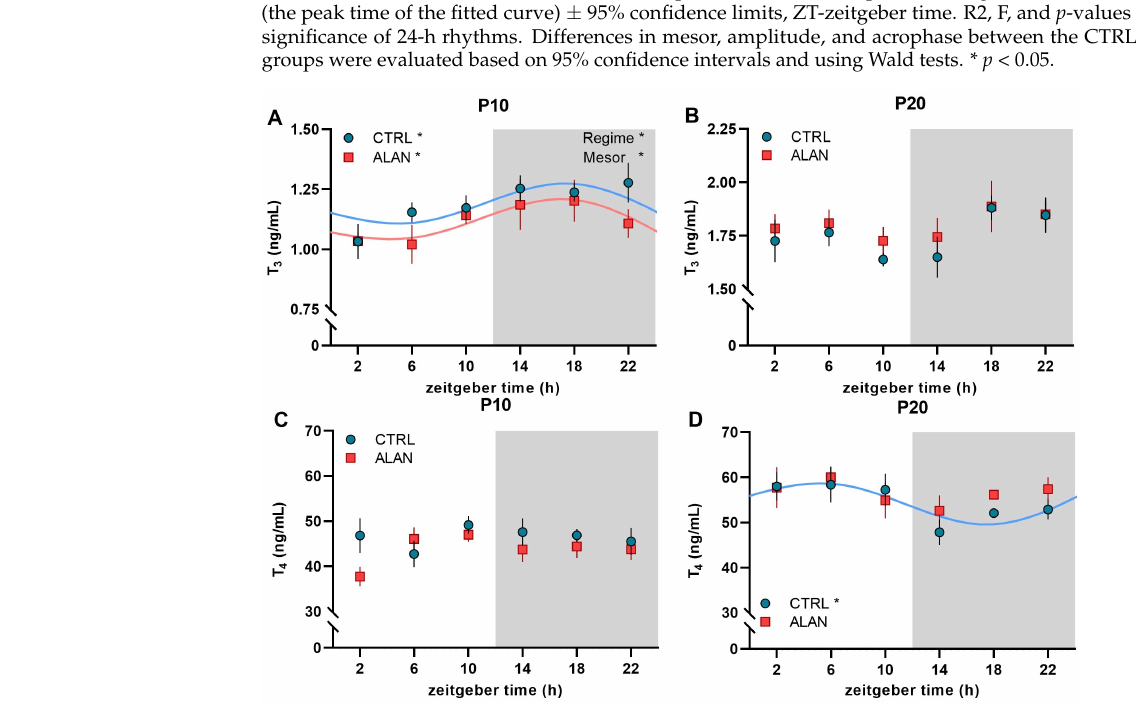
Figure 4. Effects of gestational dim ALAN (~2 lx) on the early development of daily rhythms in thyroid hormones. A daily profile of plasma triiodothyronine—T 3 ( A , B ) and thyroxine—T 4 ( C , D ) levels on postnatal days P10 ( A , C ) and P20 ( B , D ) in rat pups that were delivered by mothers exposed to either the control light–dark cycle (CTRL) or ALAN during pregnancy. Symbols represent the mean ± SEM, n = 4–6 rats per time point and group. The significant 24-h rhythms are fitted with a cosine curve for CTRL (blue solid line) and ALAN (red solid line) groups at * p < 0.05. Non-rhythmic data are not fitted with the cosine curve. Significant difference in mesor of the rhythms is indicated at * p < 0.05. Significant main effects of Regime from two-way ANOVA are indicated at * p < 0.05. Zeitgeber time 0 = light on. Grey area represents the dark phase. Note different scales in T 3 ( A , B